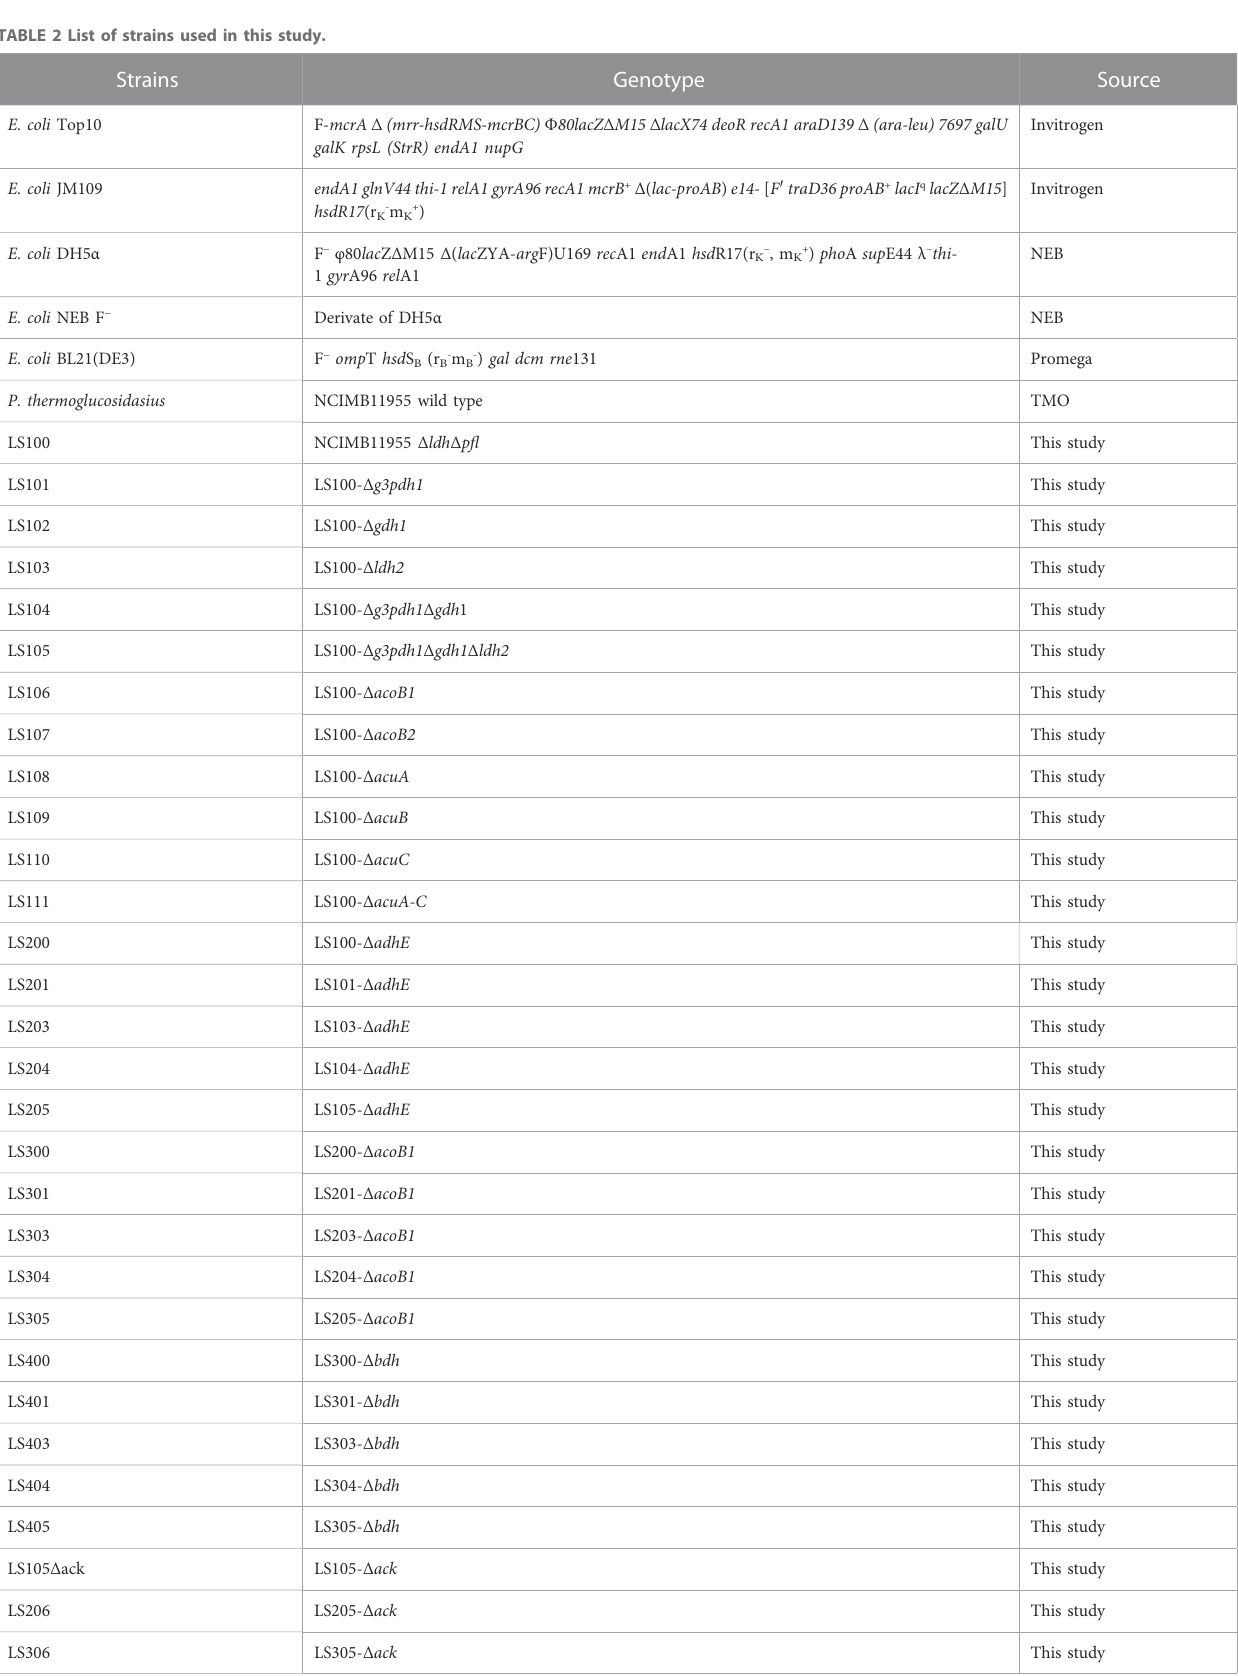
TABLE 2 List of strains used in this study. Strains